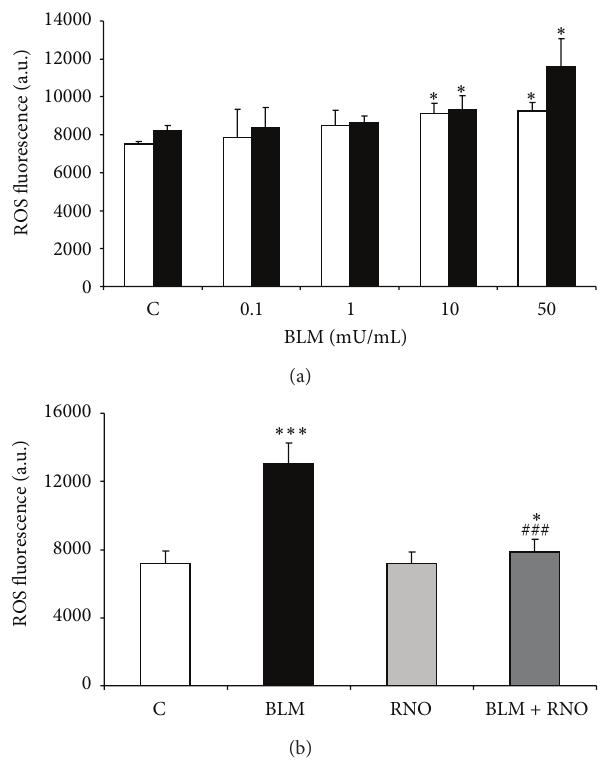
Figure 2: BLM-induced oxidative stress in HLF. (a) HLF were treated with various concentrations of BLM, and the generation of ROS was evaluated at 4 (white bar) and 24 (black bar) h. ROS levels were measured using the probe 2 󸀠 ,7 󸀠 -dichlorodihydrofluorescein diacetate (H 2 DCFDA). ROS production was determined over a 60min period. (b) The effect of RNO on the formation of ROS was evaluated in HLF from 3 different cell lines preincubated for 30 min in presence or absence of RNO (2nM) and then treated with BLM (50mU/mL) for 24 h. The results are expressed as arbitrary units of fluorescence measured on a PerkinElmer Applied Biosystems fluorescence plate reader (excitation 490nm; emission 535nm). Data are mean ± SD of 3 experiments. ∗ 𝑃 < 0.05 versus control (C); ∗∗∗ 𝑃 < 0.001 versus control (C); ### 𝑃 < 0.001 versus BLM.